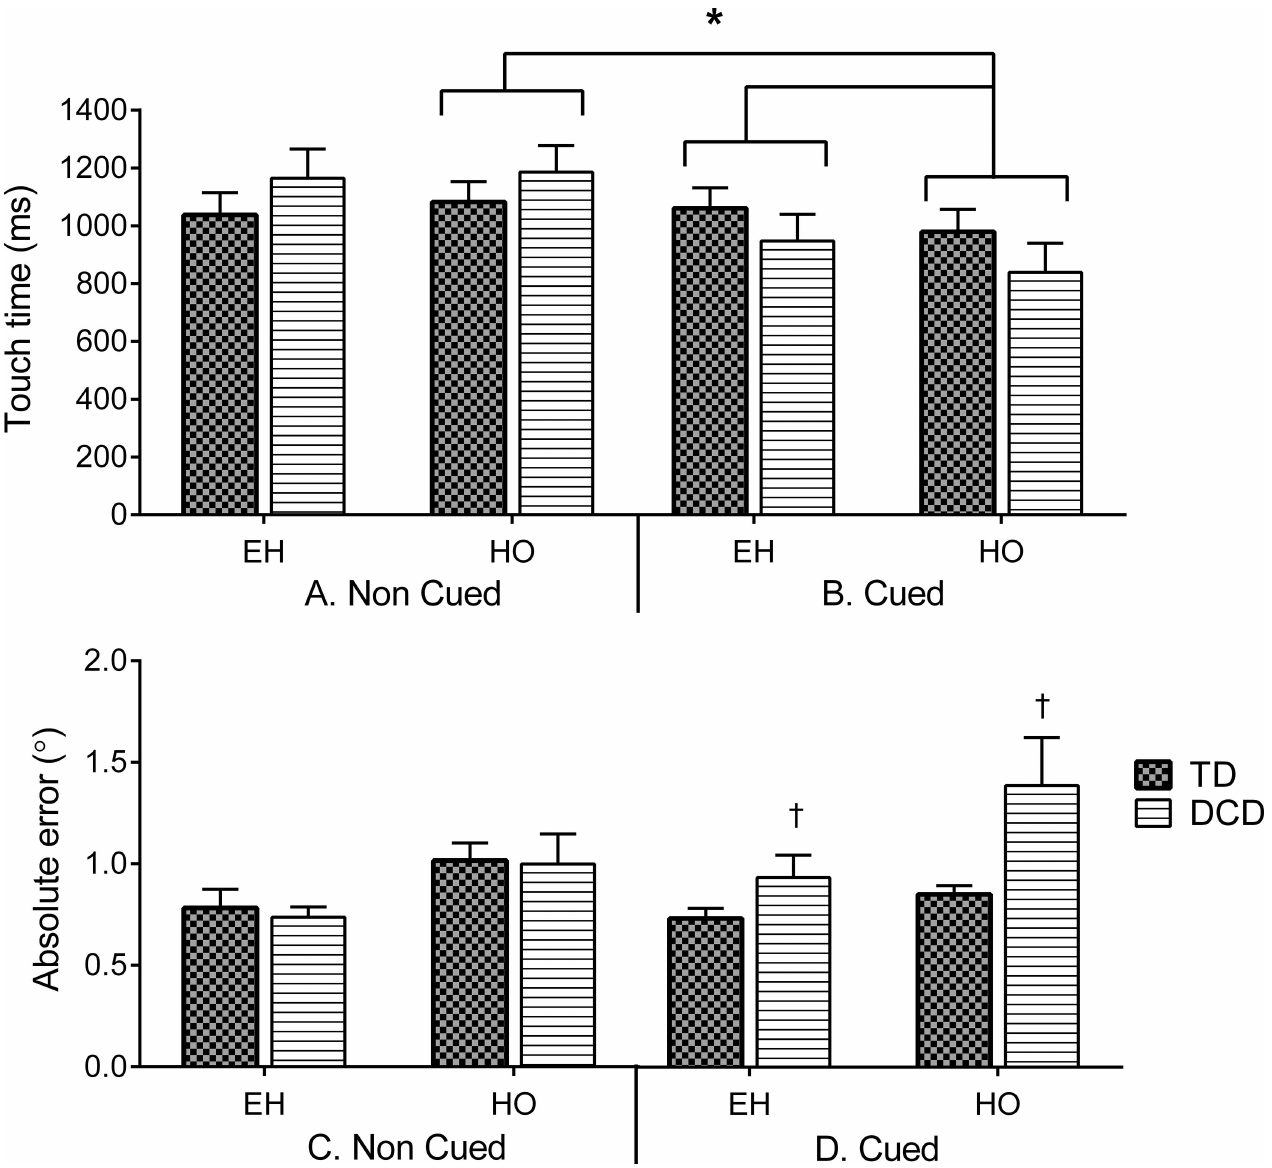
Fig 5. Mean Non-Cued(A) and Cued (B) touch times (and SEM) from target onset across coordinated(EH) and hand only (HO) tasks. Both groups decreasedHO touch times in the Cued comparedto the Non-Cuedconditionsand compared to EH (Cued HO, * ). Decreases in touch time seemed to be more evident in the DCD group (~ 343 ms difference) compared to the TD group (~ 100 ms difference), however, this result did not reach statistical significance. Lower panel . Mean Non-Cued (C) and Cued (D) touch accuracy (as mean absolute error and SEM) across EH and HO tasks. Childrenwith DCD (striped columns) were less accurate compared to TD children (grey columns) in Cued (D) conditions (DCD vs. TD, †).